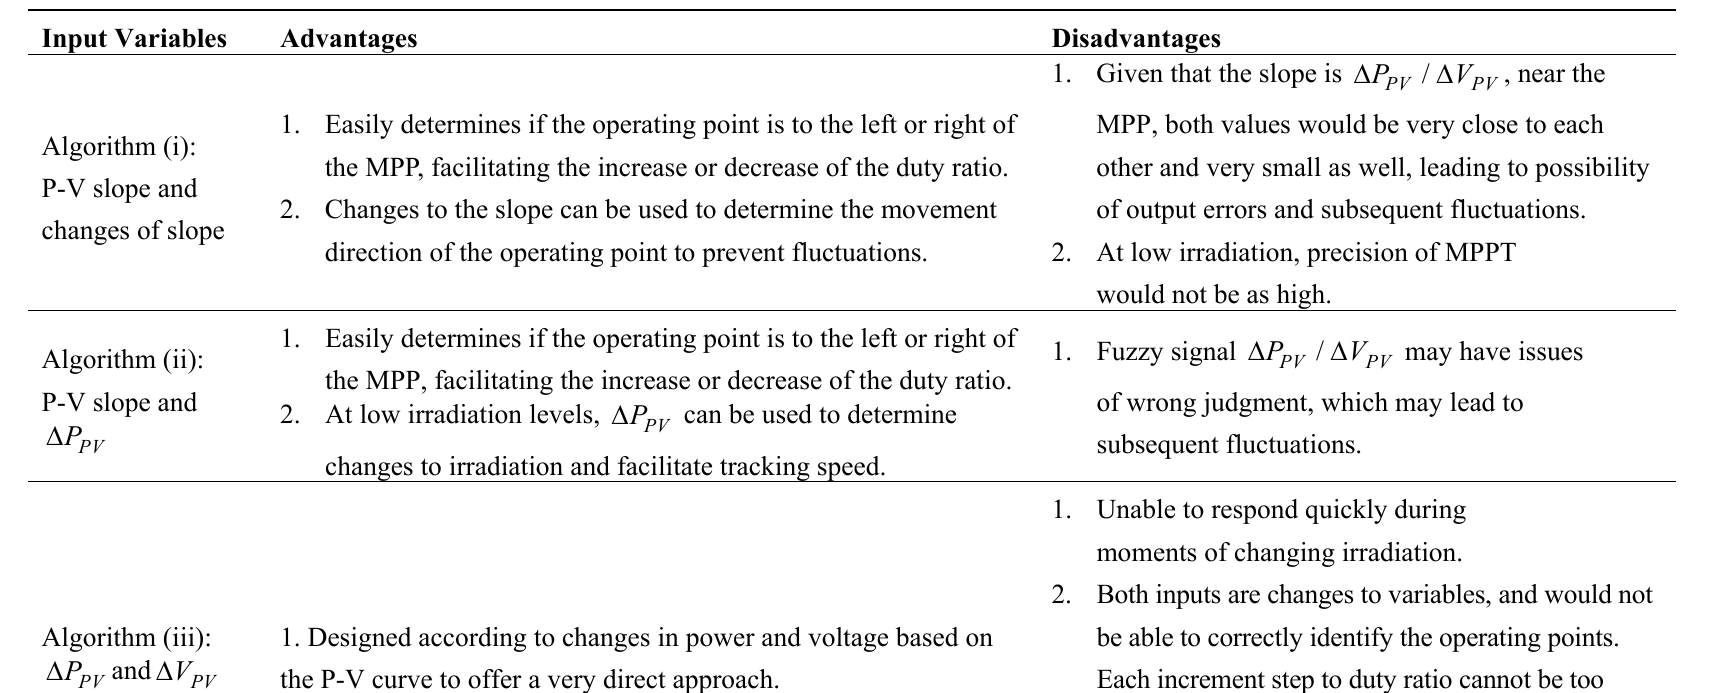
Table 1. Advantages and disadvantages of the MPPT